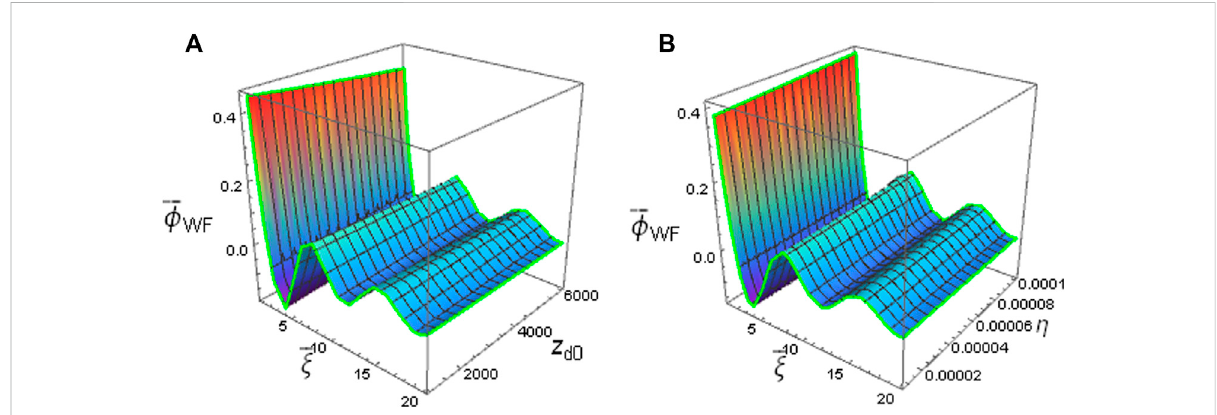
FIGURE 1 The pro fi les of WF potential ( (cid:2) ϕ WF ) are displayed against the normalized axial distance ( (cid:2) ξ ) as a function of (A) dust charging state 1000 ≤ z d 0 ≤ 6000with η ≃ 10 – 6 and (B) dustconcentration10 – 4 ≤ η ≤ 8×10 – 6 with z d 0 =4007atconstantspeed v T ((cid:1) 0 . 3 C D ) .Allotherparametersarethesameas mentioned in Section